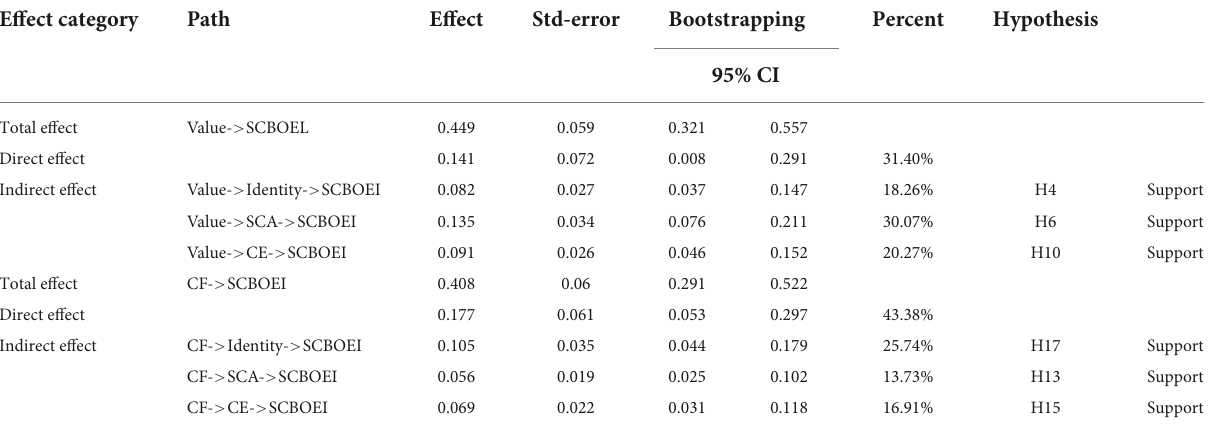
TABLE 12 Intermediary effect